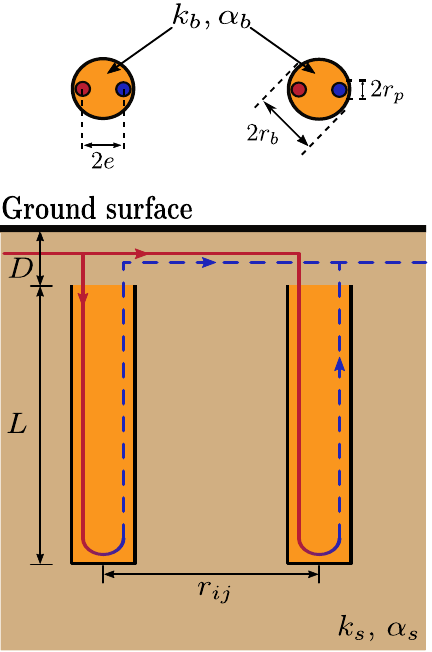
Figure 1. Field of 2 vertical boreholes of equal